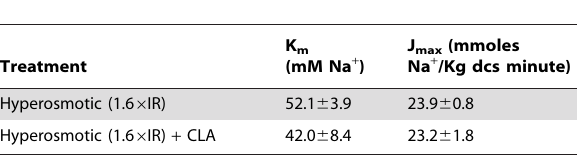
Table 1. Na + transport kinetic constants for NHE1 in Amphiuma RBCs maximally stimulated to steady-state in hyperosmotic (1.6 6 IR) media with or without 500 nM CLA